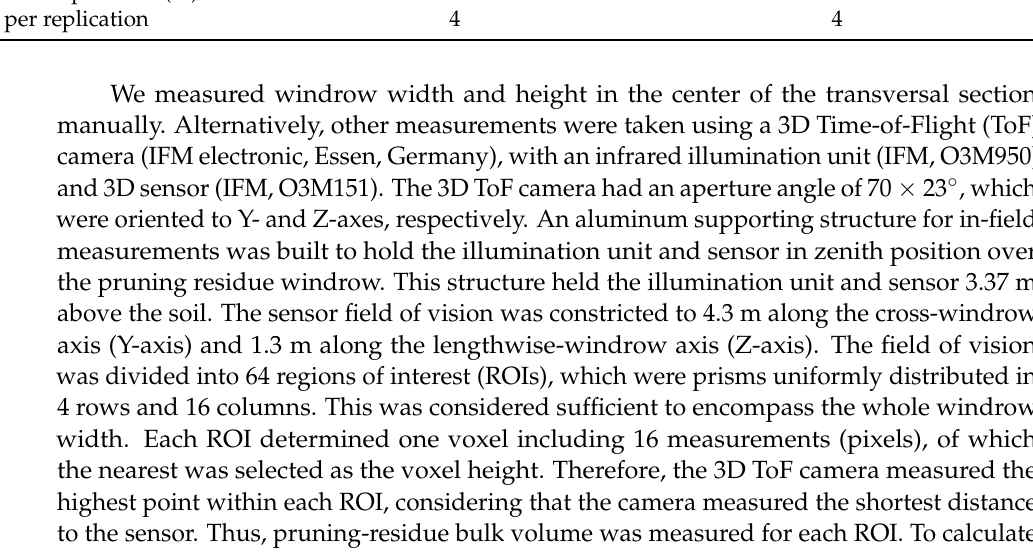
Third Branches Supporting Bearing